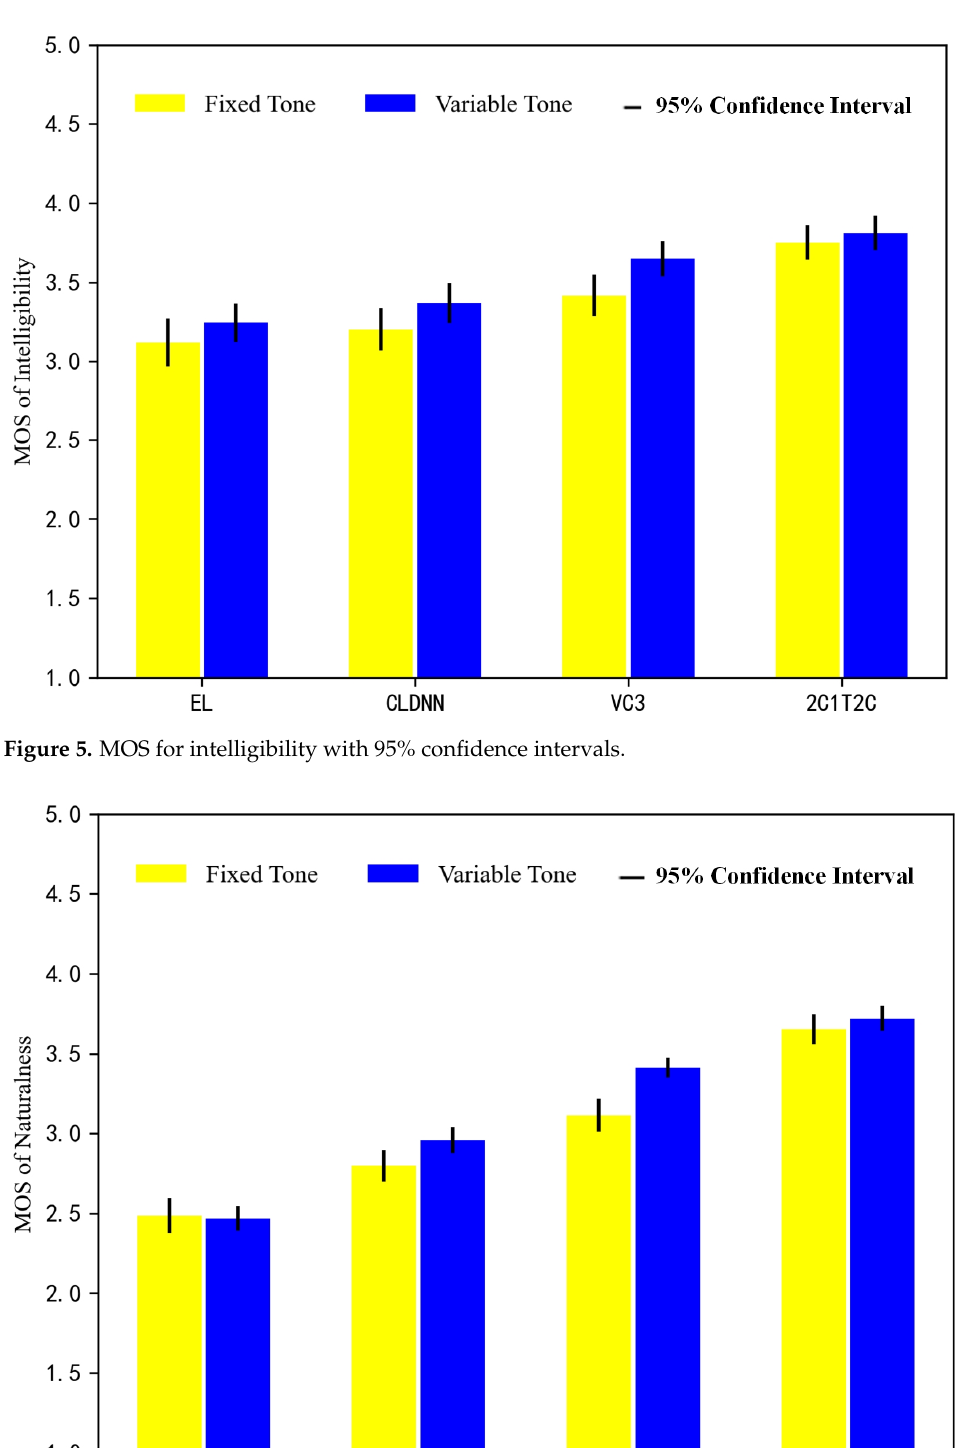
Figure 6. MOS for naturalness with 95% confidence intervals. In Figure 6, EL represents the naturalness MOS of EL − FT and EL − VT; CLDNN rep- resents the naturalness MOS of CLDNN − FT and CLDNN − VT; VC3 represents the natu- ralness MOS of VC3 − FT and VC3 − VT; and 2C1T2C represents the naturalness MOS of 2C1T2C − FT and 2C1T2C − VT. The confidence interval here is 95%.